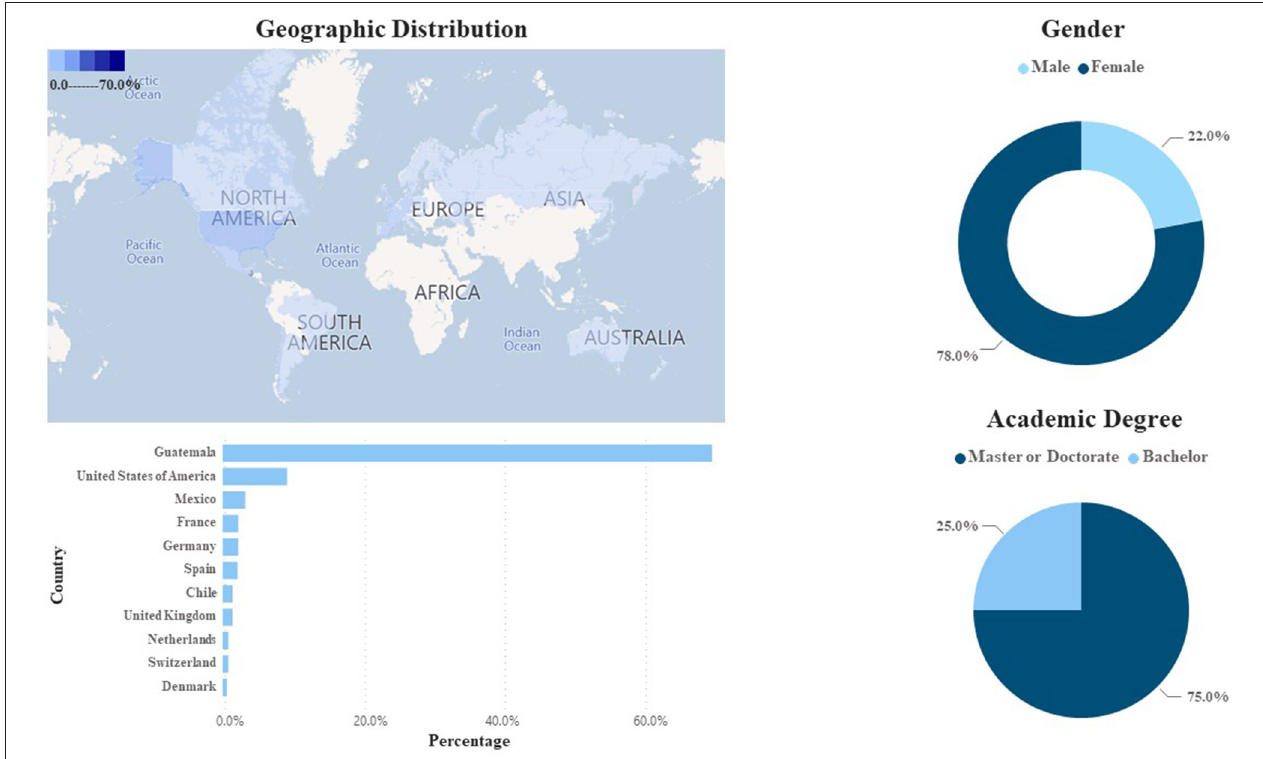
FIGURE 2 | Geographical, area of knowledge, gender, and academic degree distribution of the scientists of the international network of Guatemalan scientists RedCTI (February 2022).